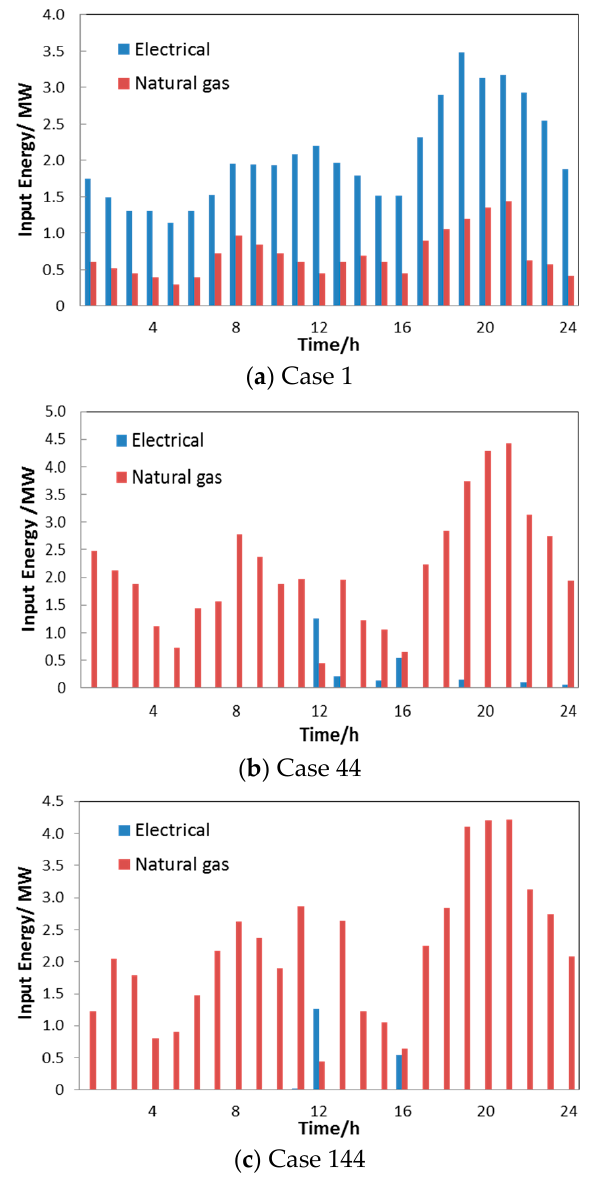
Figure 11. The input electricity and natural gas (Cases 1, 44, and 144).